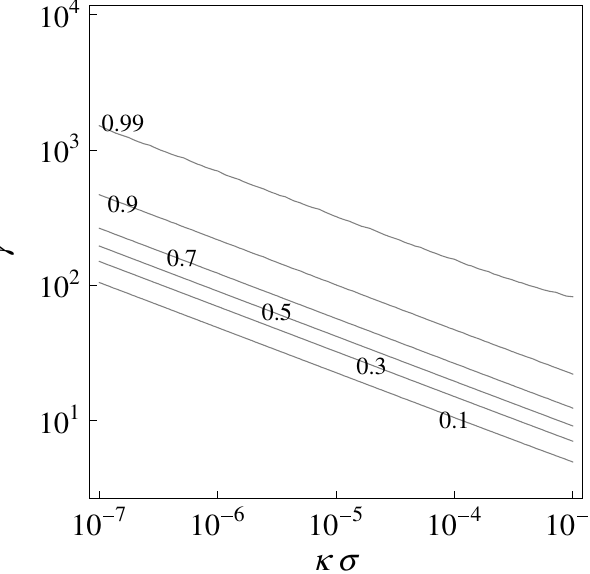
FIG. 5. The ratio of the average energy of a Gaussian bunch using the exact Eq. (32) to that using approximate Eq. (36) in a practical range of the parameters (cid:6) and (cid:7)(cid:10)